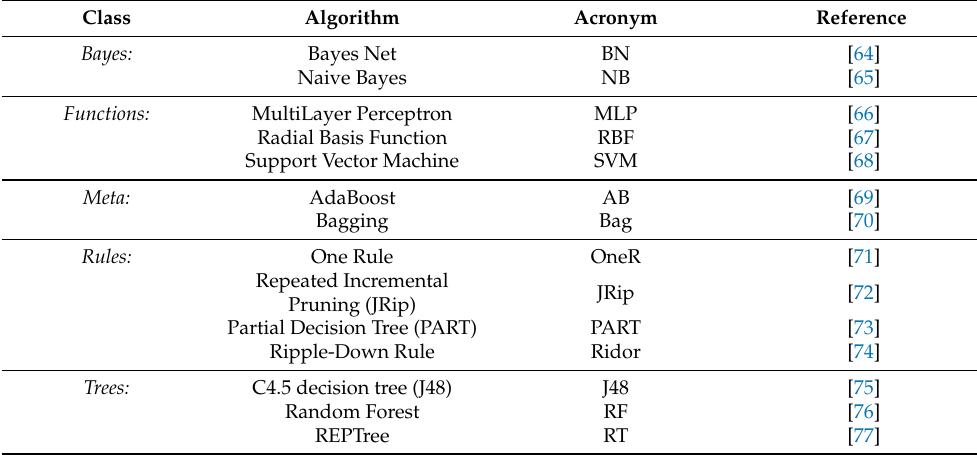
Table 4. The classification algorithms contained in WEKA and used in this paper.